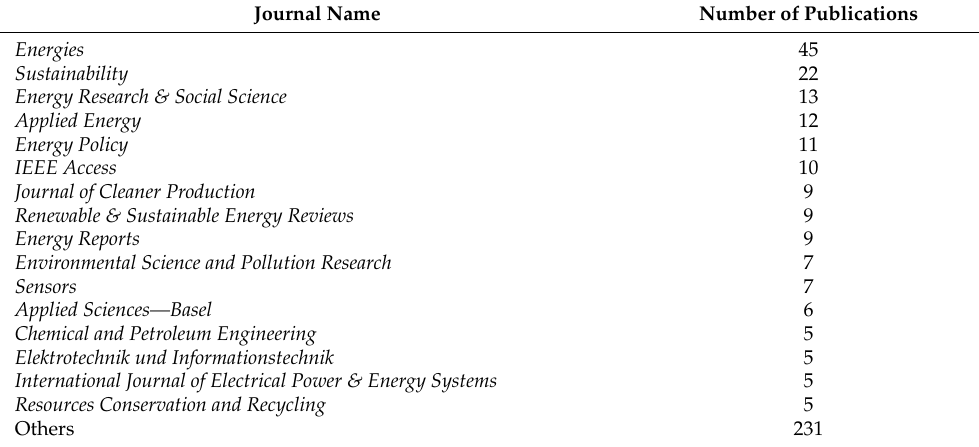
Table 1. The number of publications in each journal indexed in Web of Science 1